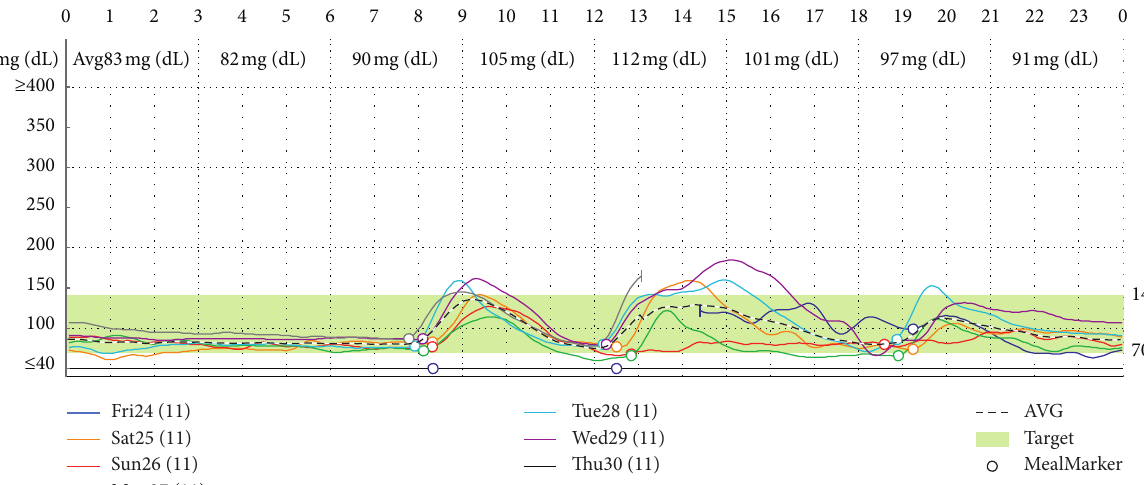
Figure 1: Results of retrospective 6-day continuous glucose monitoring (CGM) system (iPro ™ 2 system, Medtronic MiniMed, Northridge, CA, USA) in the second year (November 2017) following diagnosis revealed normal glucose levels.